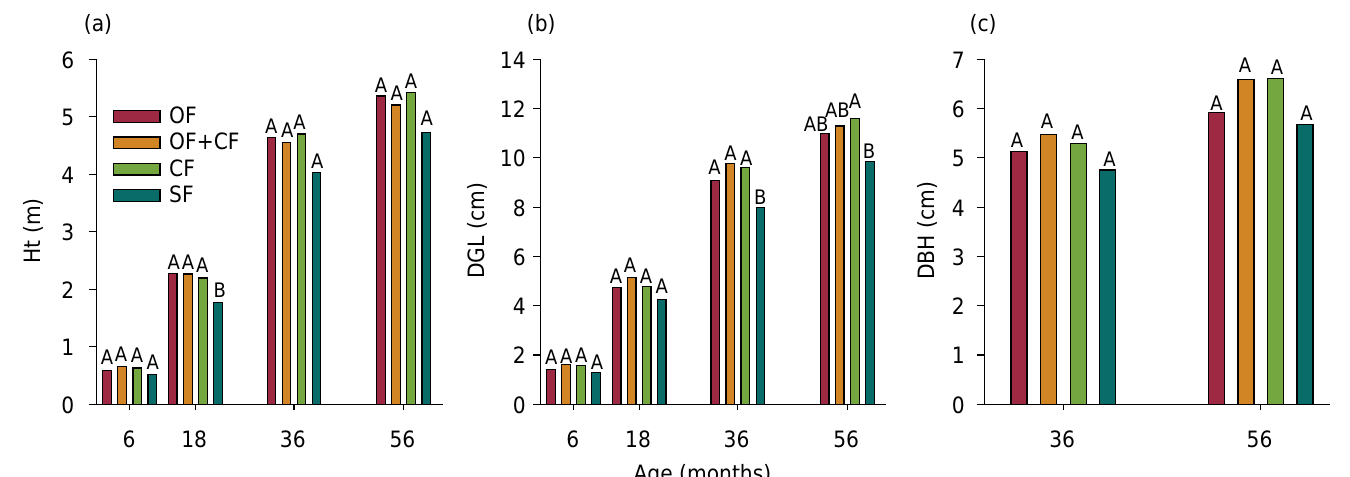
Figure 3. Total growth in height (Ht; a); trunk diameter at ground level (DGL; b); trunk diameter at breast height (DBH; c) in native forest species (Nat) at 6, 18, 36, and 56 months of age, submitted to organic (OF), combined organic and chemical (OF+CF), chemical (CF), and standard (SF) fertilizers, planted in an area of bauxite mining. Uppercase letters compare fertilization treatments within the same age and, when equal, indicate no differences between them by the Tukey’s test at 10 % probability